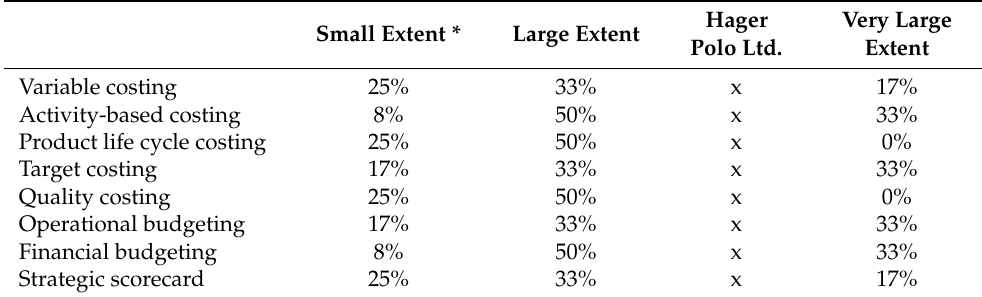
Table 2. Assessment of managerial accounting tool use in strategic decision making. Hager Very Large Small Extent * Large Extent Polo Ltd. Extent Variable costing 25% 33% x 17% Activity-based costing 8% 50% Product life cycle costing 0% Operational budgeting 17% 33% x 33% Financial budgeting 8% 50% x 33% Strategic scorecard 25%